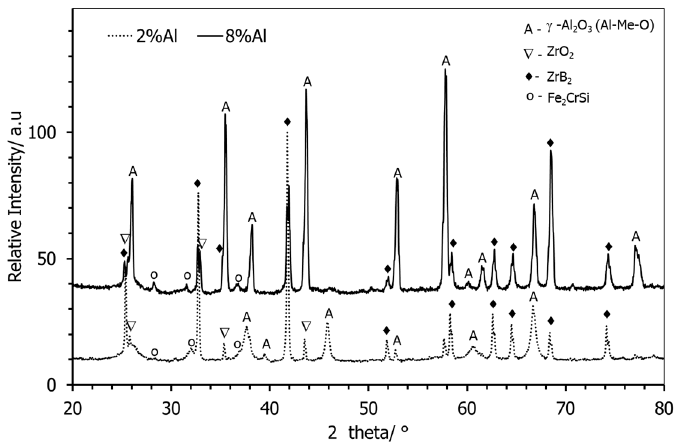
Figure 11. X-ray diffraction pattern of the ablated front side of the samples.